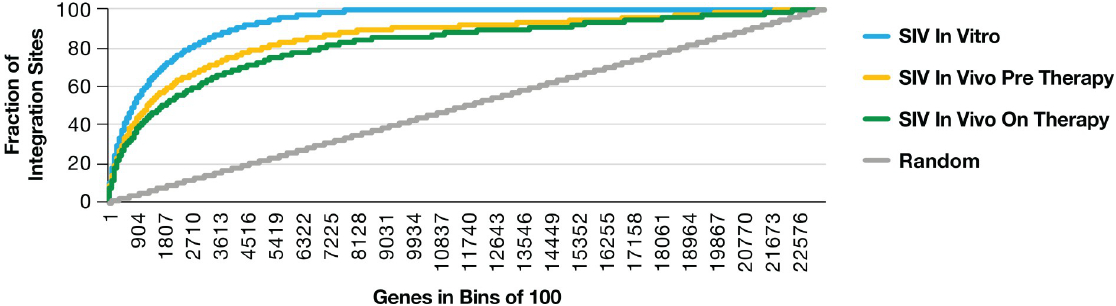
Fig 5. The overall distribution of SIV integration sites in macaque PBMC infected in vitro is similar to the distribution of integration sites in samples taken from infected macaques pre-ART (both 2-week and 4-week samples) and on-ART. For the in vivo pre-ART and on-ART analysis, the data from all the infected macaques was combined. Genes were placed in bins of 100 based on the frequency of integration sites in the genes in SIV infected macaque PBMC. Each point on the Y axis represents the cumulative fraction of integration sites in all of the bins to the left of that point of the X axis. The in vitro integration site data are shown in blue, the in vivo pre-ART data are shown in yellow, the in vivo on-ART data are shown in green, and a computer-generated random control data are shown in gray.